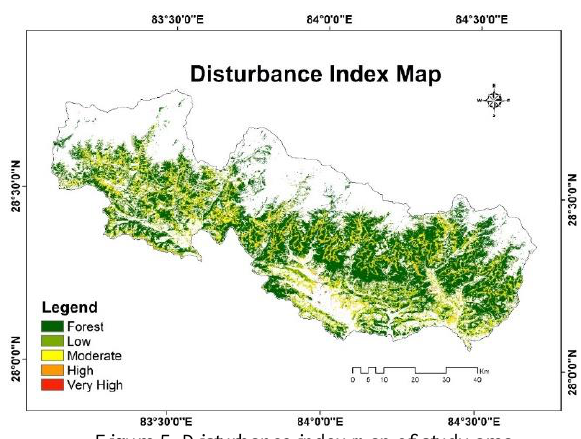
Figure 5. Disturbance index map of study area